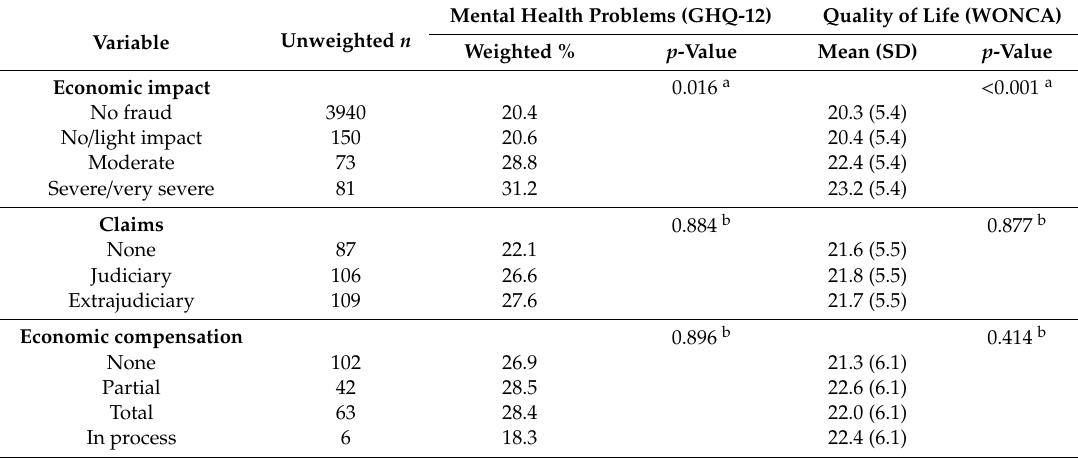
Table 3. Prevalence of caseness (GHQ-12) and average quality of life (COOP / WONCA) according to financial fraud